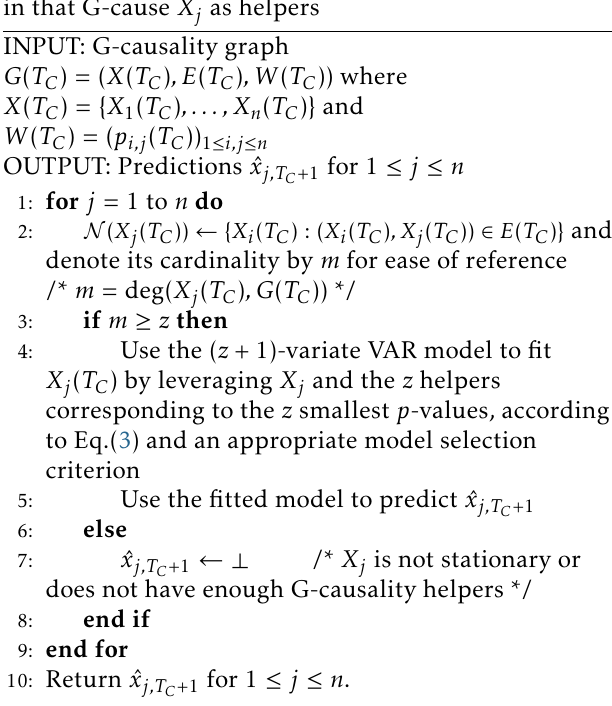
Algorithm 1 The GC( z + 1)VAR algorithm for predict-